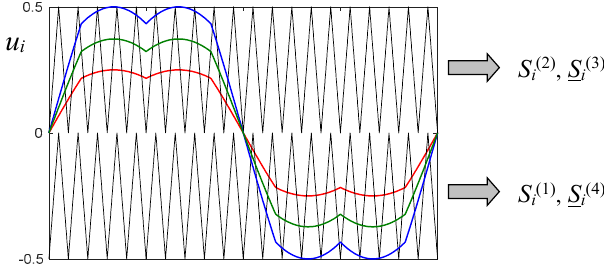
Figure 2. Carrier-based CPWM modulation logic for each leg ( i ) of three-level FC inverter in case of m = 0.577/2 (red trace), m = 0.43 (green trace) and m = 0.577 (blue trace). Underline denotes complementary.